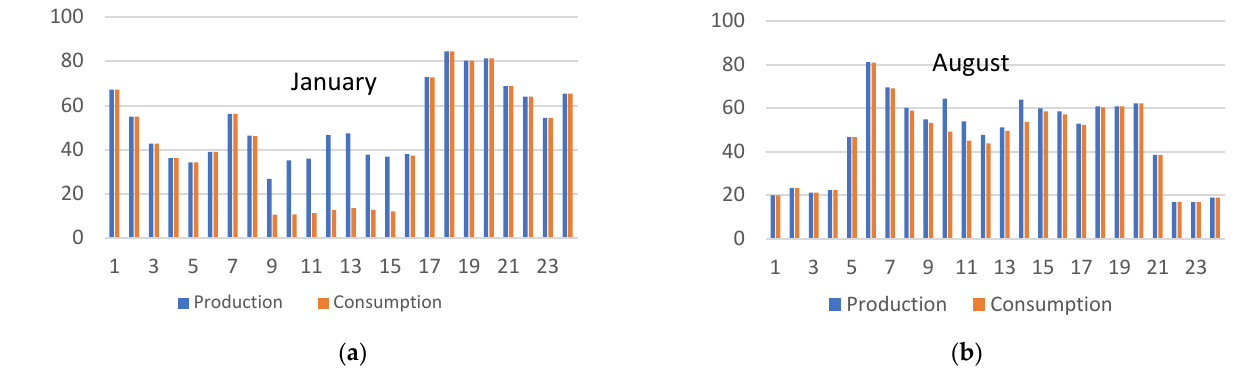
Figure 10. Daily average electricity production and load consumption over the reporting period,